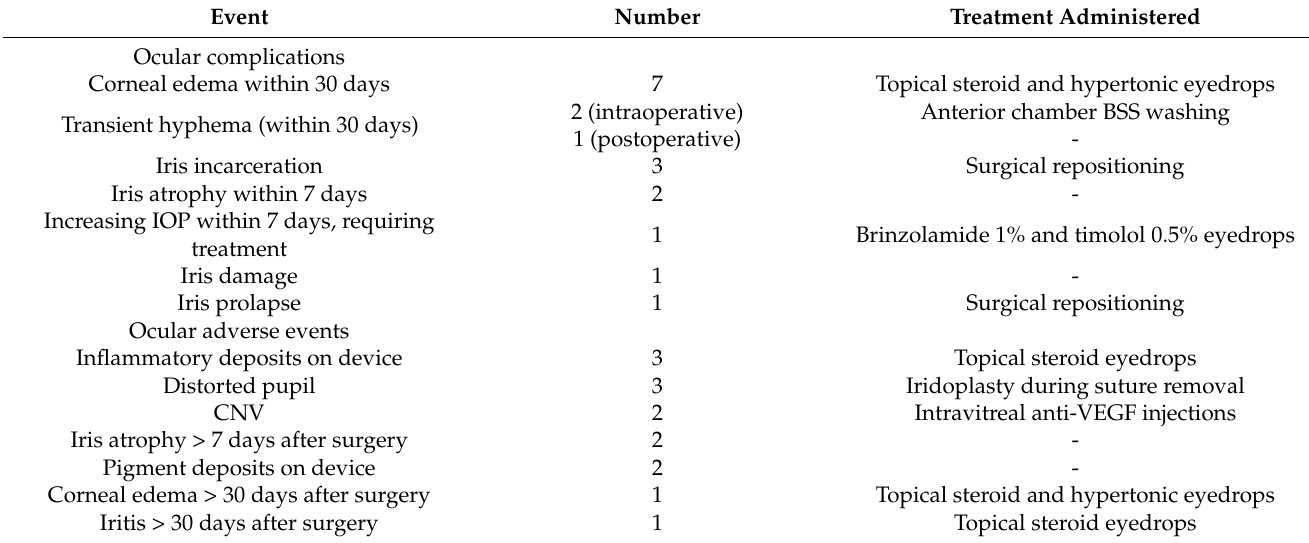
Table 3. Ocular complications and adverse events in study and fellow eyes and the respective treatments